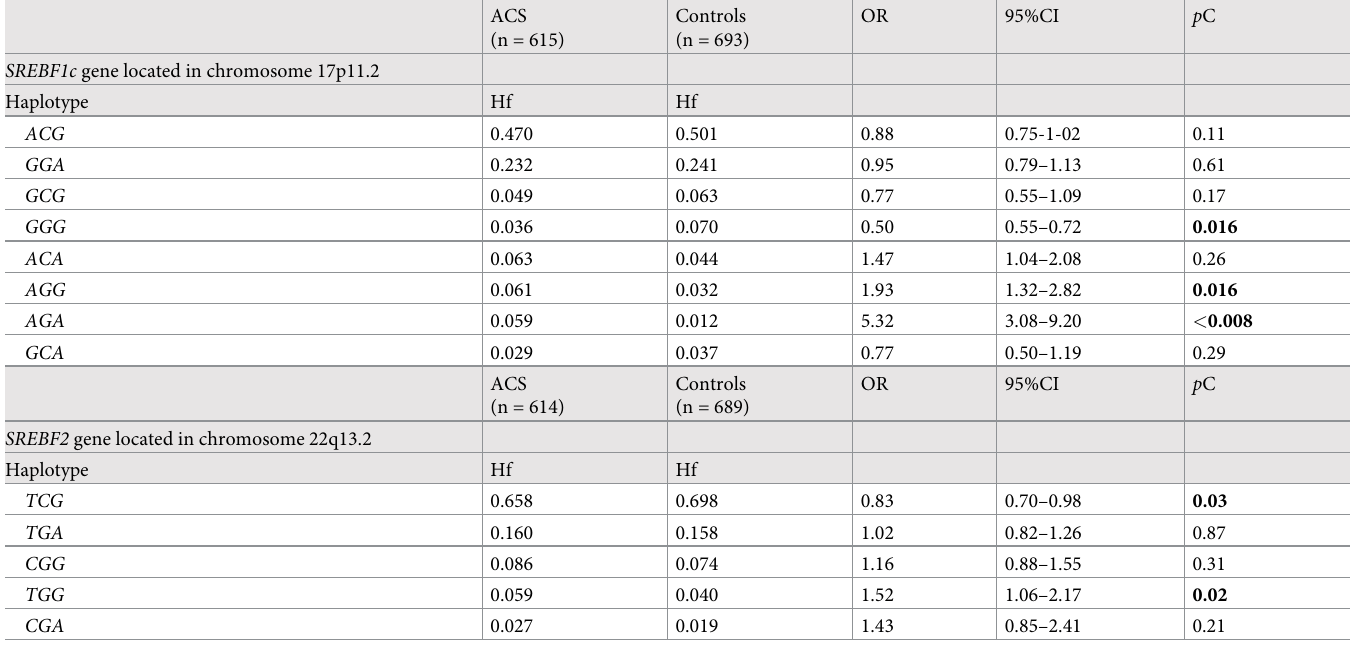
Table 3. Haplotype distribution of SREBF1c and SREBF2 polymorphisms in ACS patients and healthy controls.